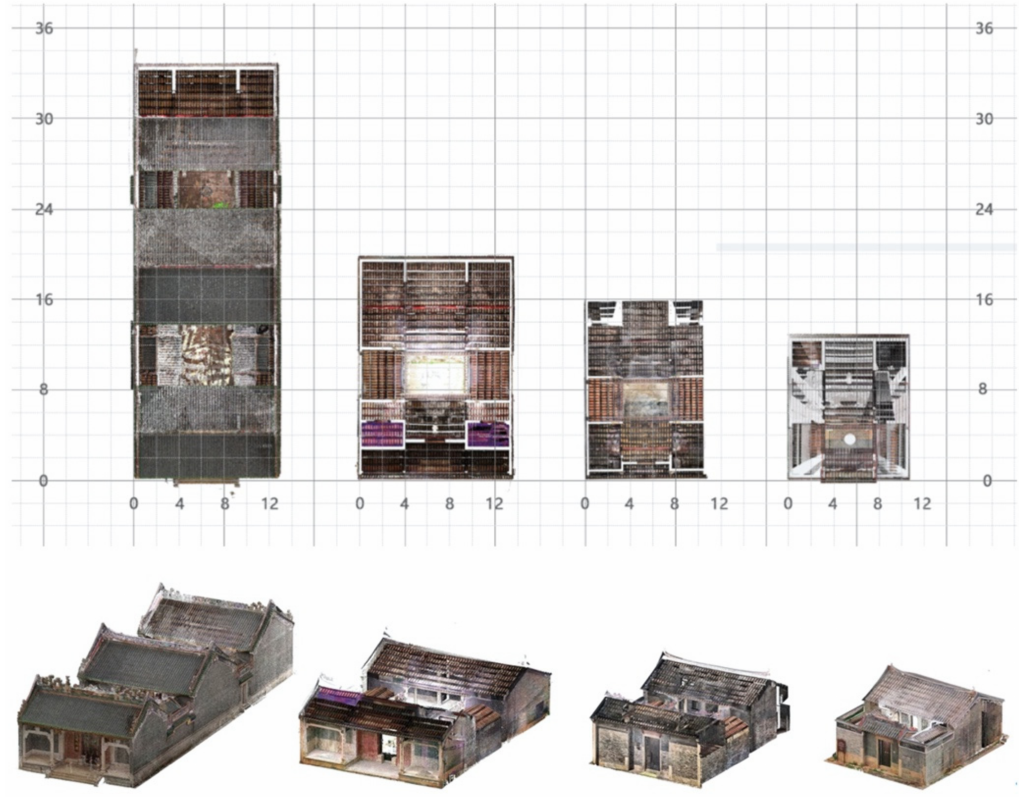
Figure 7. Comparison of ancestral halls (layout). The four ancestral halls are compared in this figure, from left to right, they are Wen Family Ancestral Hall, Songzhuang Ancestral Hall, Yichen Ancestral Hall, and Sisheng Ancestral